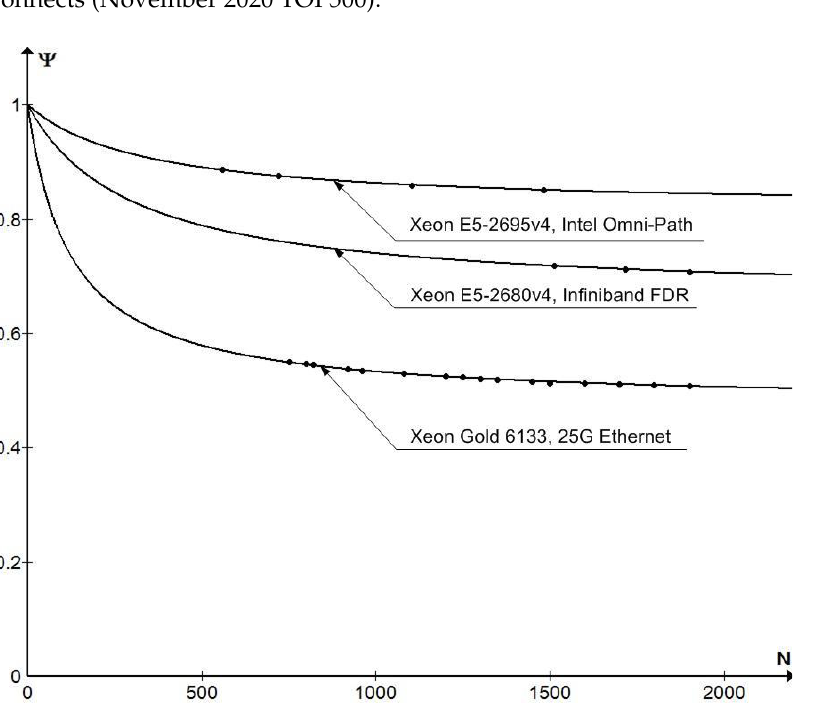
Figure 2. Dependence of the coefficient of Ψ (N) = R max /R peak on the number of nodes N in clusters (November 2020 TOP500).